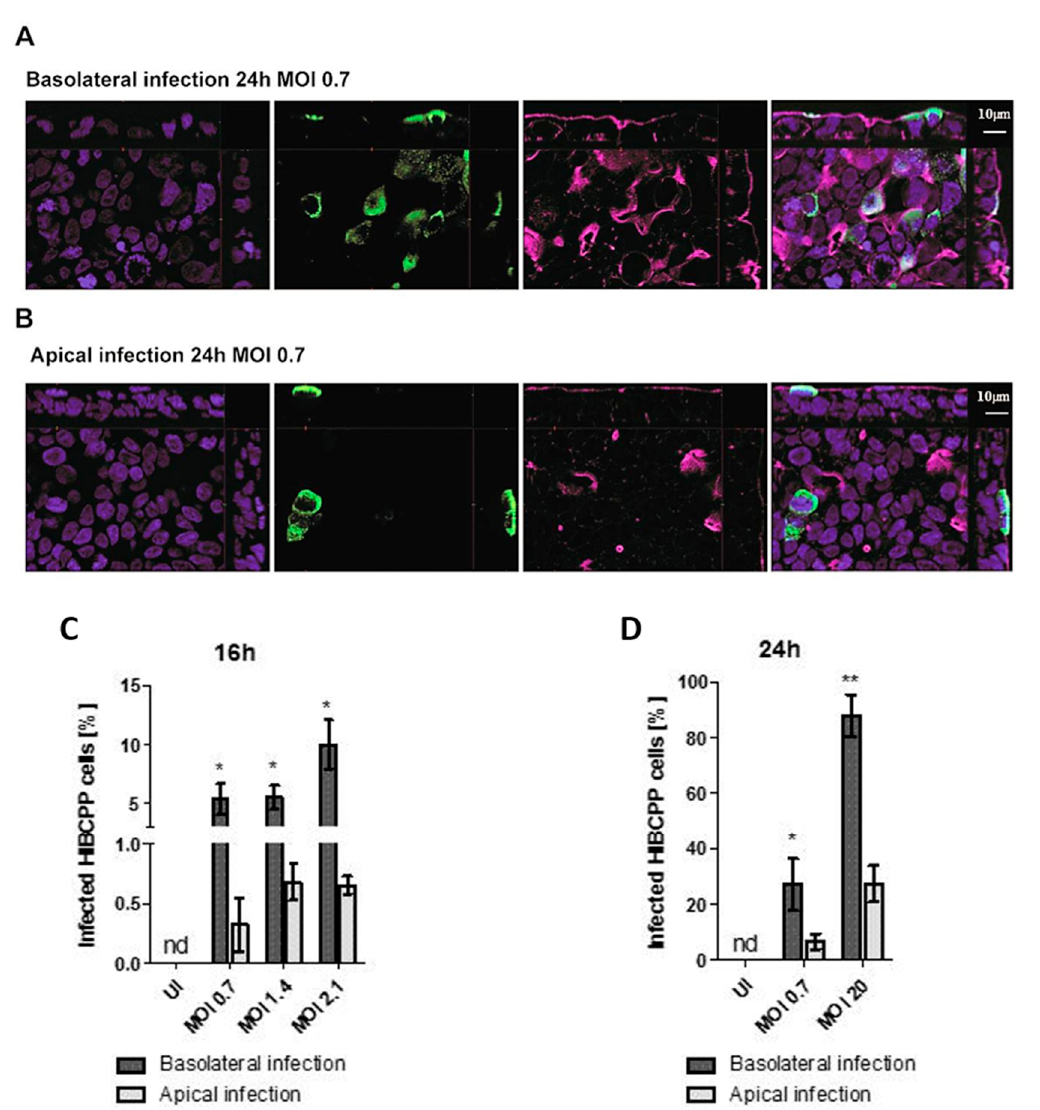
Figure 4. The number of infected HIBCPP cells following basolateral infection is greater compared to apical infection with E-30 at MOI 0.7 for 24 h. Immunofluorescence imaging of HIBCPP cell layers following 24 h of infection with E-30 on the basolateral side ( A ) or apical side ( B ). Nuclei are stained with DAPI (blue), HIBCPP cells infected with E-30 are stained with anti-PAN entero (green), and actin is stained with phalloidin (purple). Stacks were acquired using Zeiss Apotome and Zen software with an X63 / 1.4 objective lens. Scale bars are indicated in the figure. Quantification of HIBCPP cells with E-30 infection from the basolateral and apical side following 16 h ( C ) and 24 h ( D ) with di ff erent MOI (MOI 0.7, 1.4, 2.1 and MOI 0.7, 20, respectively). The data are shown as mean ± SD of 3 independent experiments, each performed in duplicates. Statistical significance was calculated using a Student’s t -test. p -values are displayed as follows; * p < 0.05 and ** p < 0.001. The statistical analysis was performed with the software GraphPad